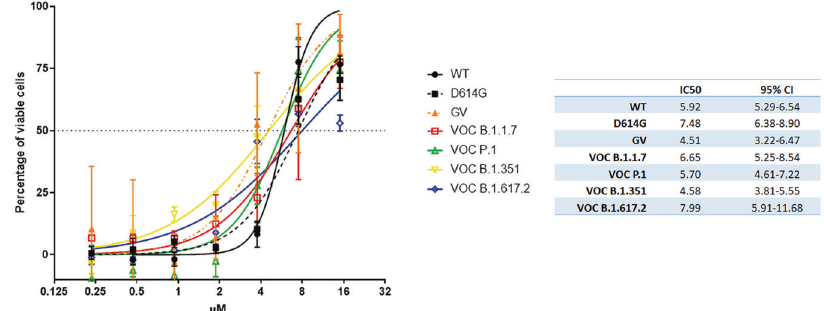
Fig. 3 Raloxifene reduces the CPE induced by SARS-CoV-2 variants in Vero E6 cells. The graph shows the inhibition of CPE observed at different concentration of raloxifene on different VOCs. The IC 50 values calculated by nonlinear regression are shown in the table. Percentage of viable cells calculated on not treated not infected = 100%; not treated SARS-CoV-2 infected cells = 0%. Bars indicate